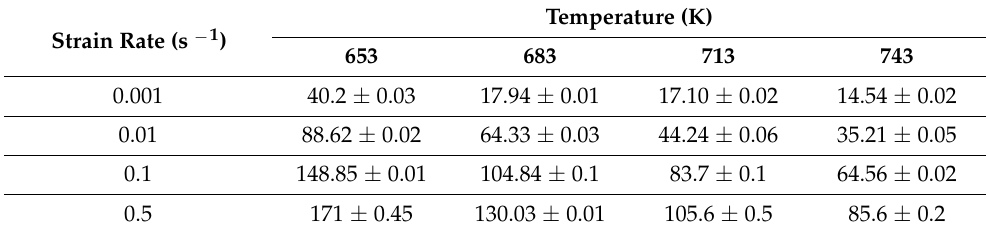
Table 2. The peak stress ( σ p ) under different deformation